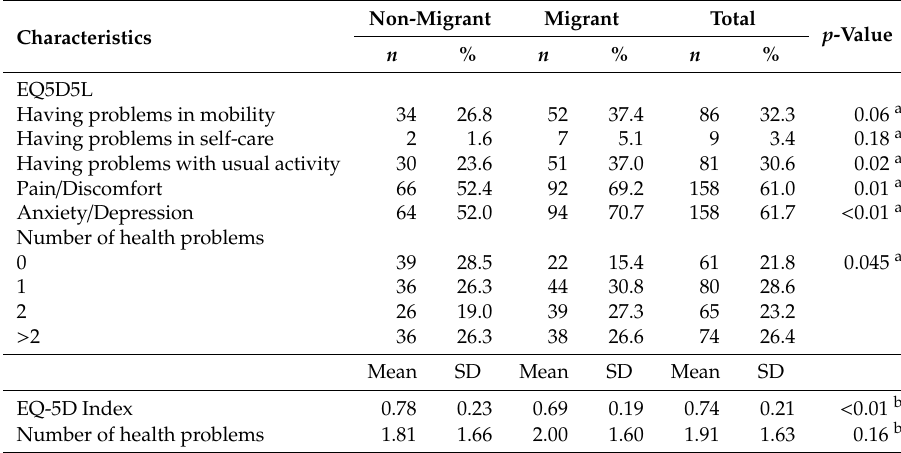
Table 3. Health status, health-related quality of life and behaviors.